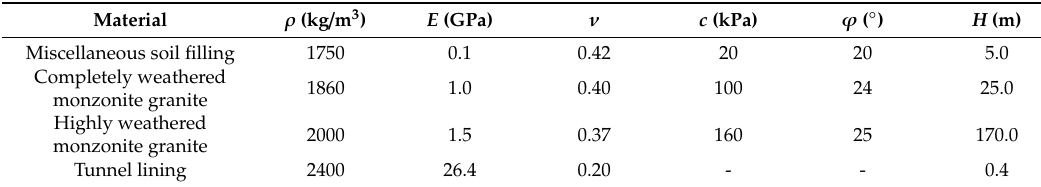
Table 2. Material properties in the numerical simulation.